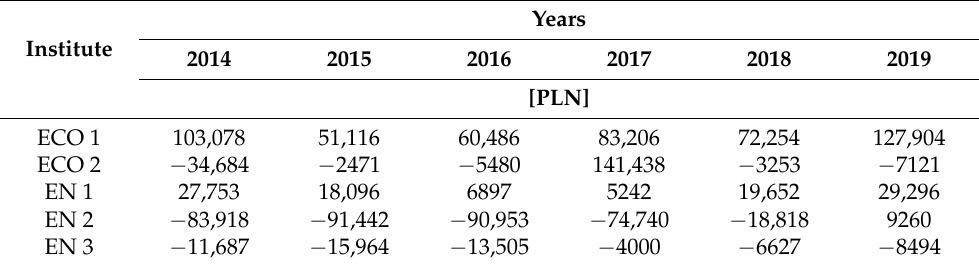
Table 4. Sales profit per employee of surveyed research institutes from 2014 to 2019.